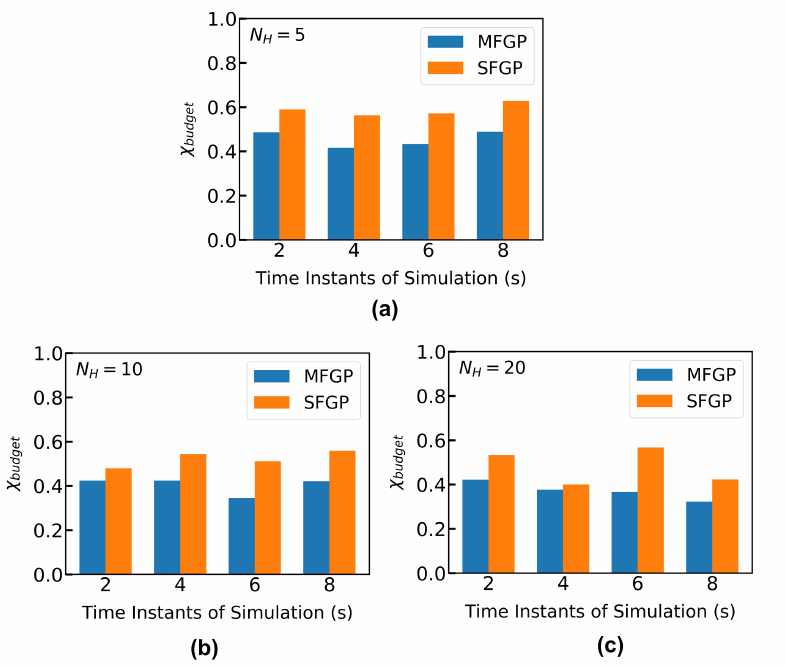
Figure 16. Optimization performance metrics for maintaining the melt pool depth at d ∗ = 1